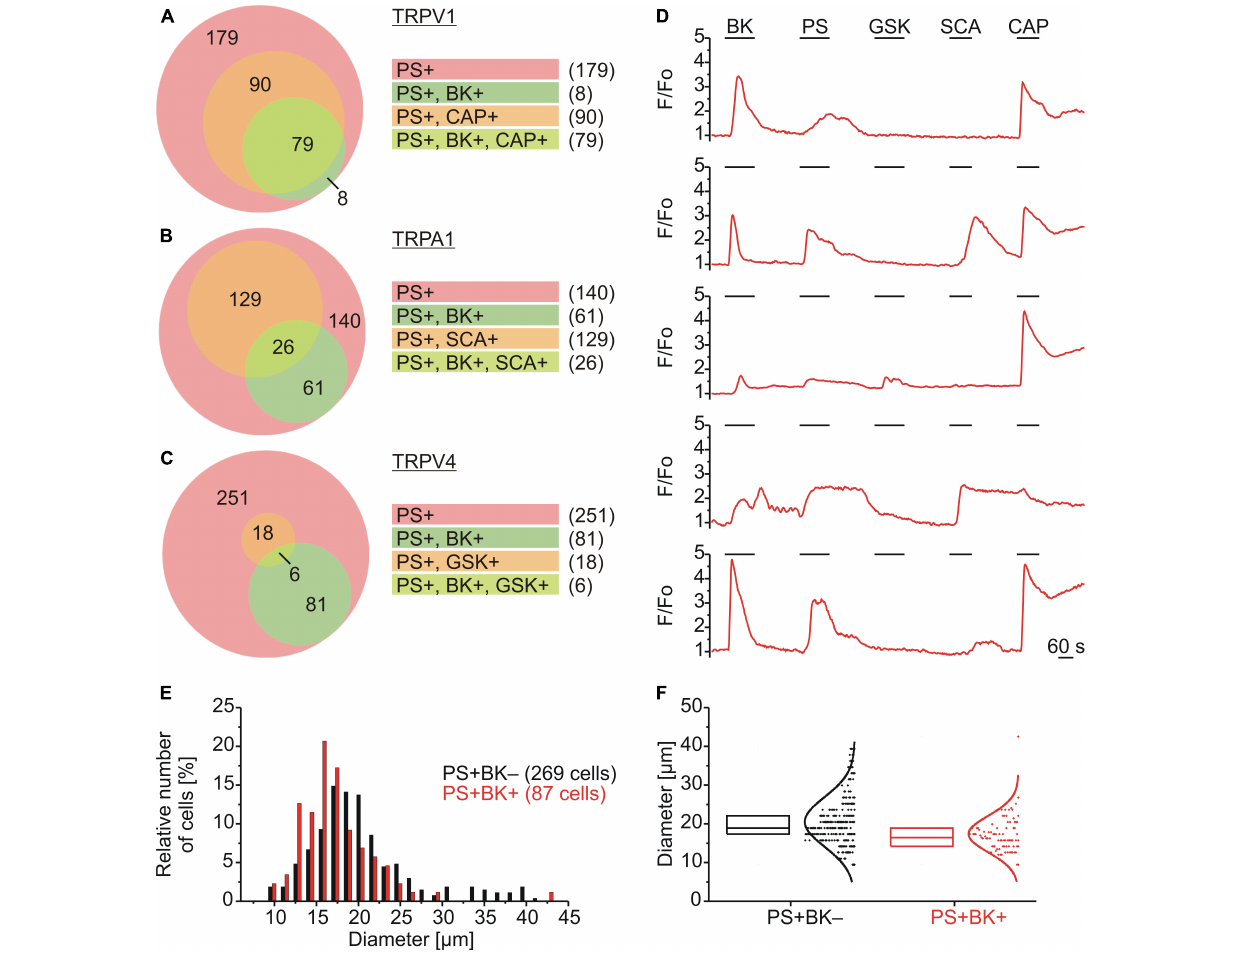
FIGURE 2 | Functional characterization and size distributions of neurons responding to PS. (A–D) DRG neurons were stimulated sequentially with bradykinin (BK; 0.5 µ M), pregnenolone sulfate (PS; 40 µ M), GSK1016790A (TRPV4 agonist; GSK; 1 µ M), supercinnamaldehyde (TRPA1 agonist; SCA; 1 µ M) and capsaicin (TRPV1 agonist; CAP; 0.5 µ M). Values are taken from neurons across eight measurements with cells from one mouse. Euler diagrams represent the relative incidence of cells responding to BK and CAP (A) , SCA (B) , and GSK (C) amongst PS responsive neurons. (D) Representative calcium traces from five individual cells. (E,F) BK-sensitive and BK-insensitive TRPM3-expressing DRG neurons have similar size distributions. The distributions of sizes (expressed as Feret’s diameter) of the cells analyzed in (A–C) are shown in a histogram with a bin size of 1.5 µ m (E) and as box plot with boxes indicating quartiles and centerline median (F) . Each dot-like symbol represents the diameter of one cell and curves represent fits by Gaussian